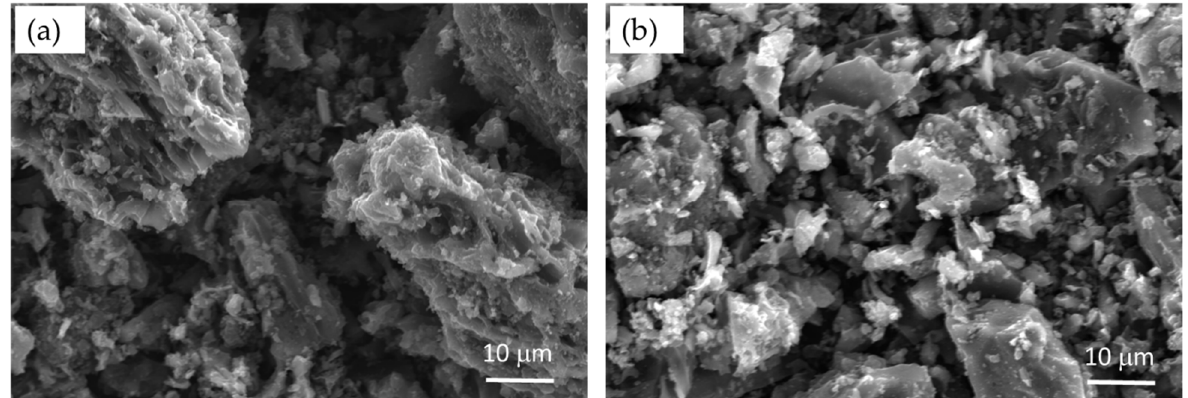
Figure 1. SEM images of ( a ) Charcoal 1 and ( b ) Charcoal 2.